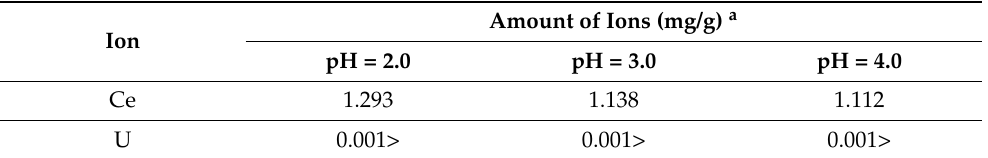
Table 3. Amount of Ce and U ions adsorbed by the interpolymer system “Amberlite IR120H:AV-17-8” (4:2) under different pH values. Amount of Ions (mg/g) a Ion pH = 2.0 pH = 3.0 pH = 4.0 Ce 1.293 1.138 1.112 U 0.001> 0.001>